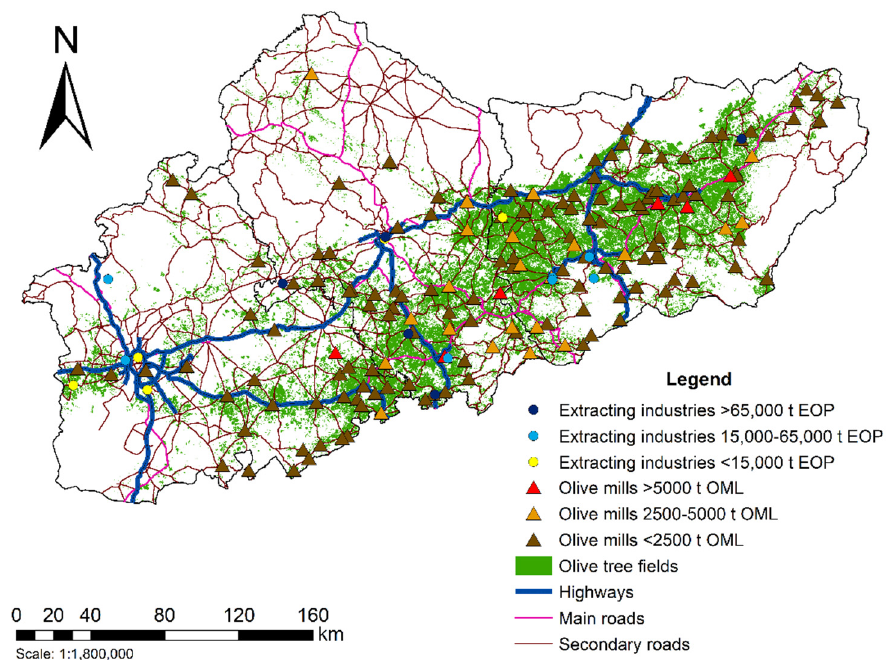
Figure 3. Geographical location of olive tree crops, olive mills and olive oil pomace-extracting in- dustries.